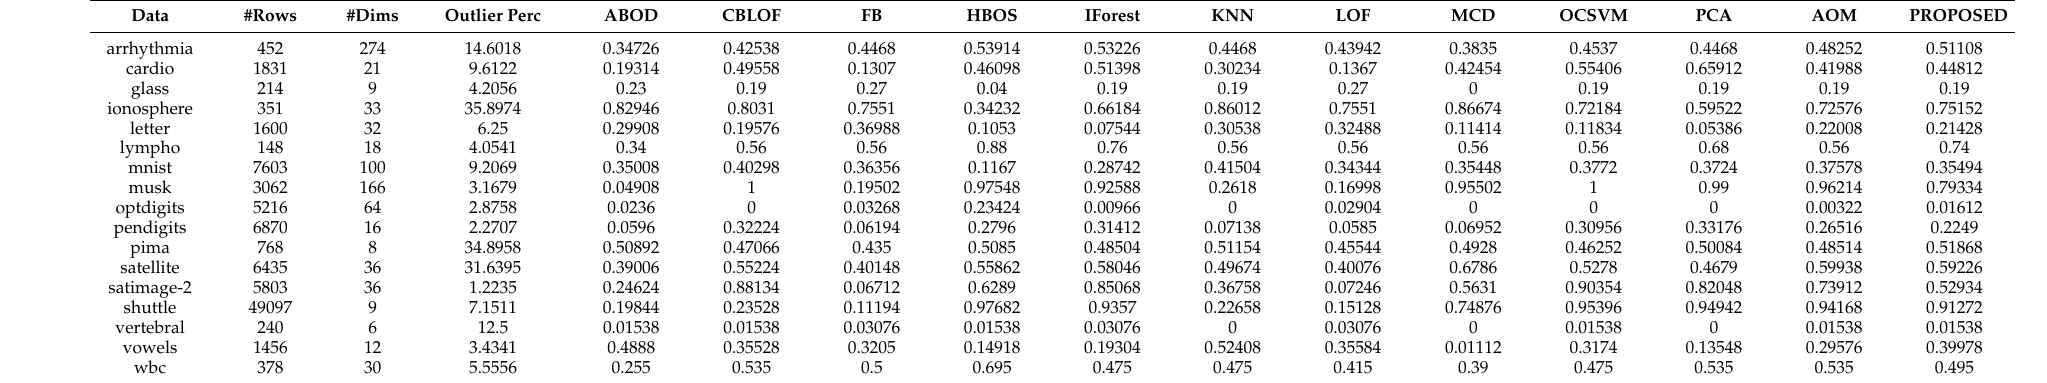
Table A2. Comparison of precision results (average of 5